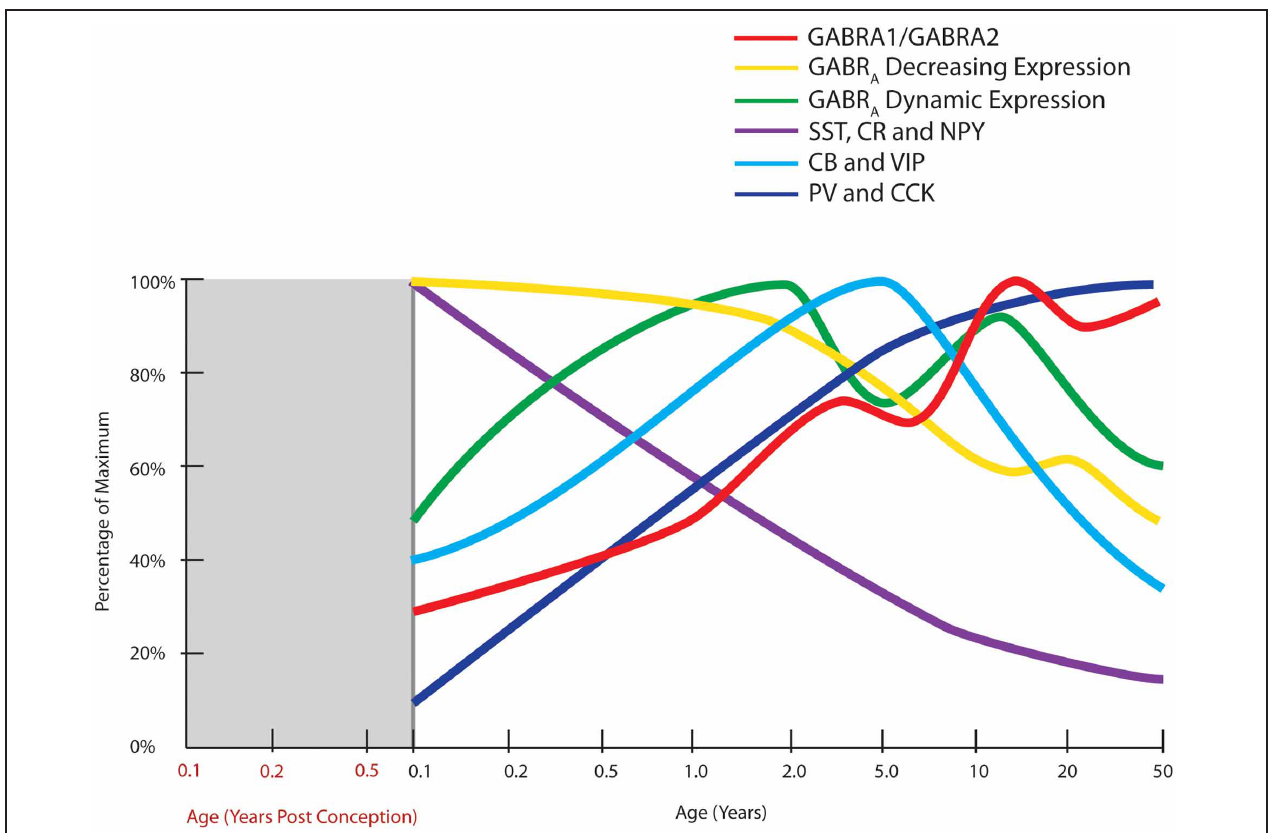
FIGURE 3 | Normal developmental trajectories of expression of inhibitory system components in the human prefrontal cortex. Normal development of GABA receptor components of the inhibitory system is dynamic until adolescence where the trajectories reach a steady or declining state. GABA A (GABR A ) subunits display two distinct patterns, one of decreasing expression following birth ( α 2, α 5, β 1, γ 1, γ 3 subunits) and a M pattern (dynamic expression) with peaks at toddler and teenage time periods ( α 1, α 4, β 2, β 3, γ 2 subunits; Fillman